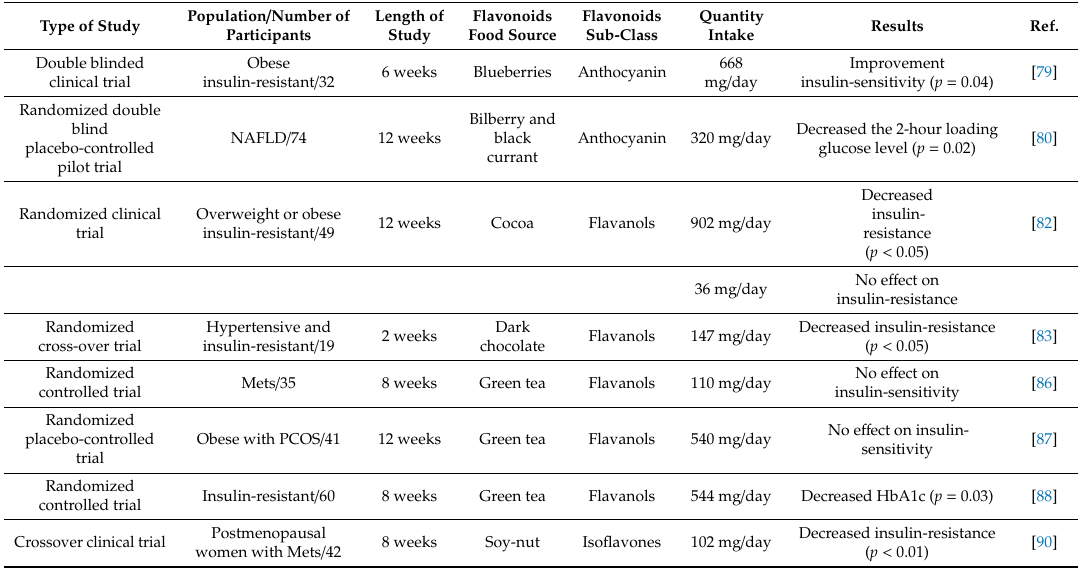
Table 5. Clinical studies evaluating flavonoids sources food intake on insulin